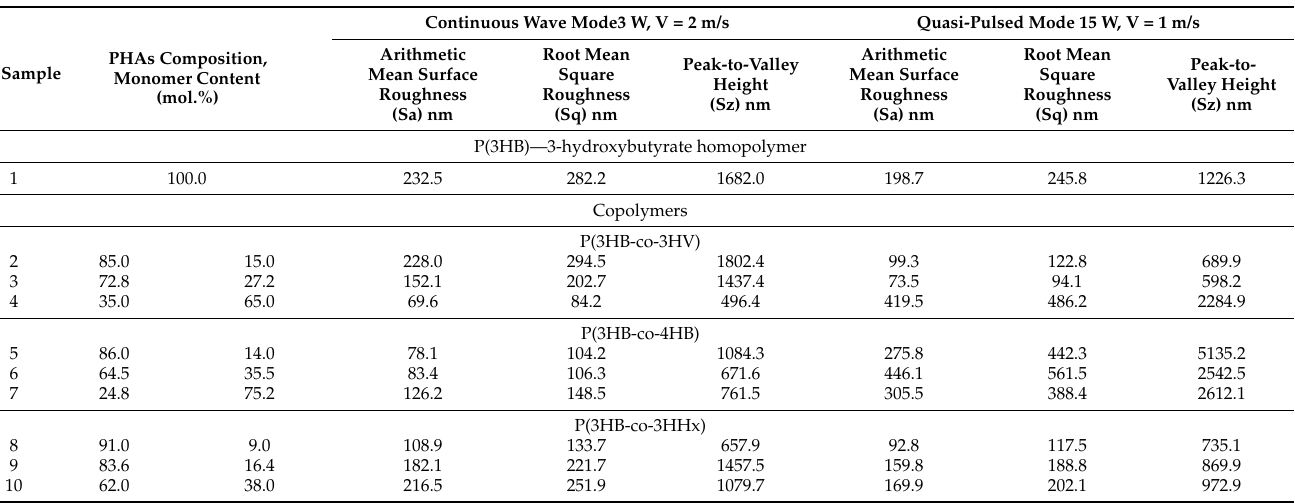
Figure 3. AFM images of surfaces of the laser-treated films prepared from PHAs with different com- positions. Table 3. Surface roughness parameters of the laser-treated films prepared from PHAs samples, based on results of atomic force microscopy (AFM).